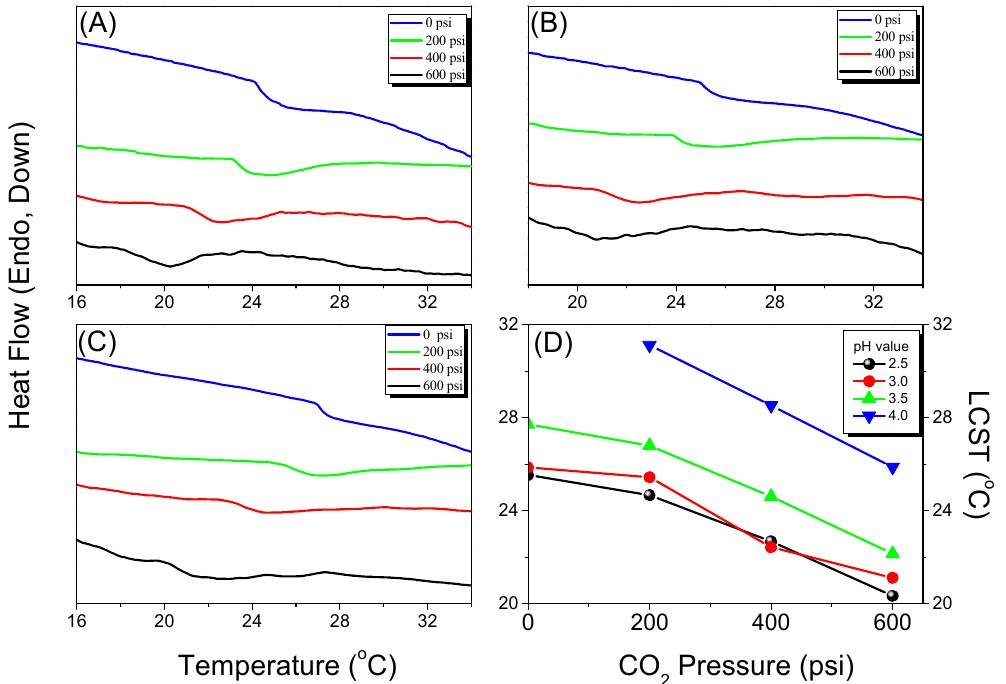
Figure 9. ( A – C ) HP-DSC first-heating curves (2 °C/min) of 5 wt % solutions of: ( A ) PNIPAAm97- co -PAA3; ( B ) PNIPAAm87- co -PAA13; and ( C ) PNIPAAm80- co -PAA20 random copolymers at various CO 2 pressures. ( D ) Corresponding LCSTs of the PNIPAAm80- co -PAA20 aqueous solutions at various values of pH.